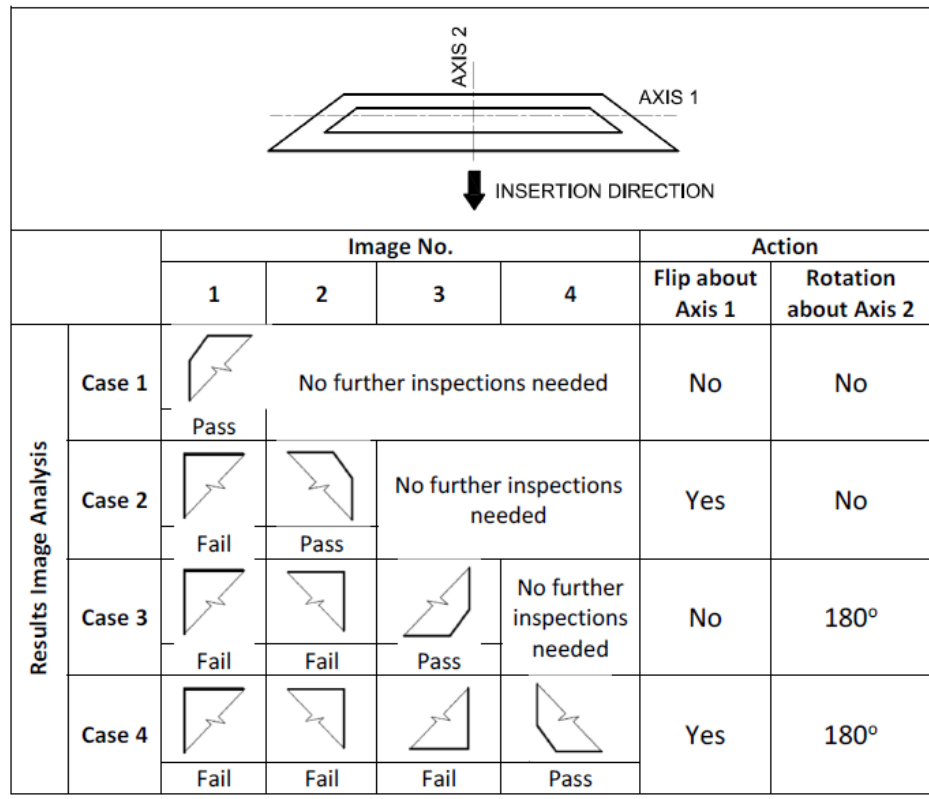
Figure 7. Machine vision process cases and the actions taken for each image analysis result. The insert shows the orientation of axes one and two relative to the insertion direction of the fuel cell component in the presenter and in fuel cell stack. Flipping the fuel cell component was achieved by passing it from one robot hand to the other. This process was equivalent to rotating the component 180° about axis one.